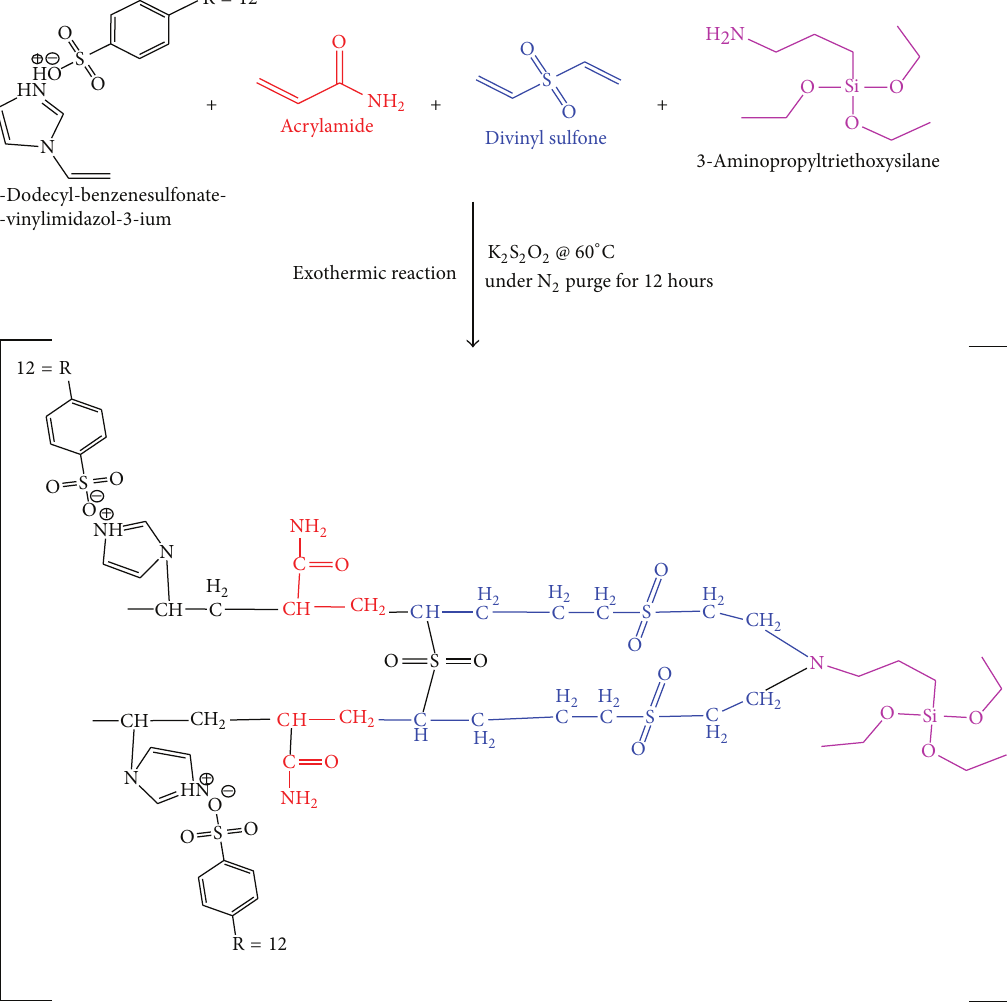
Figure 2: Chemical structure of HAPAM-SiO 2